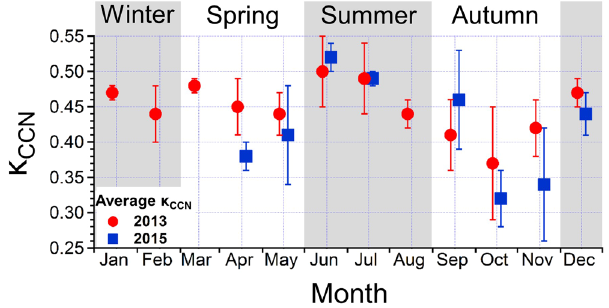
Figure 1. Time series of κ CCN of the submicron water-soluble aerosol for the year 2013 (red circles) and 2015 (blue squares). Each season is categorized by shaded